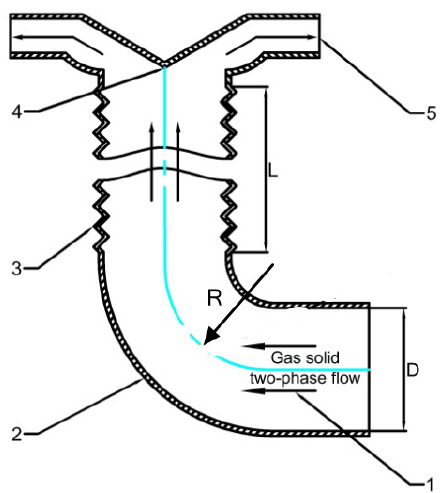
Figure 2. Vertical distributor and elbow combination. (1) two-phase flow; (2) elbow; (3) corrugated pipe; (4) top cover; (5) discharge outlet.